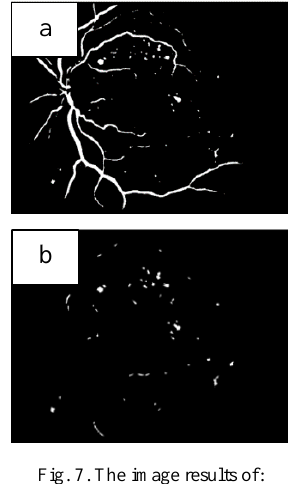
Fig. 5. The results of median filtering: (a) s1=10; (b) s2=35